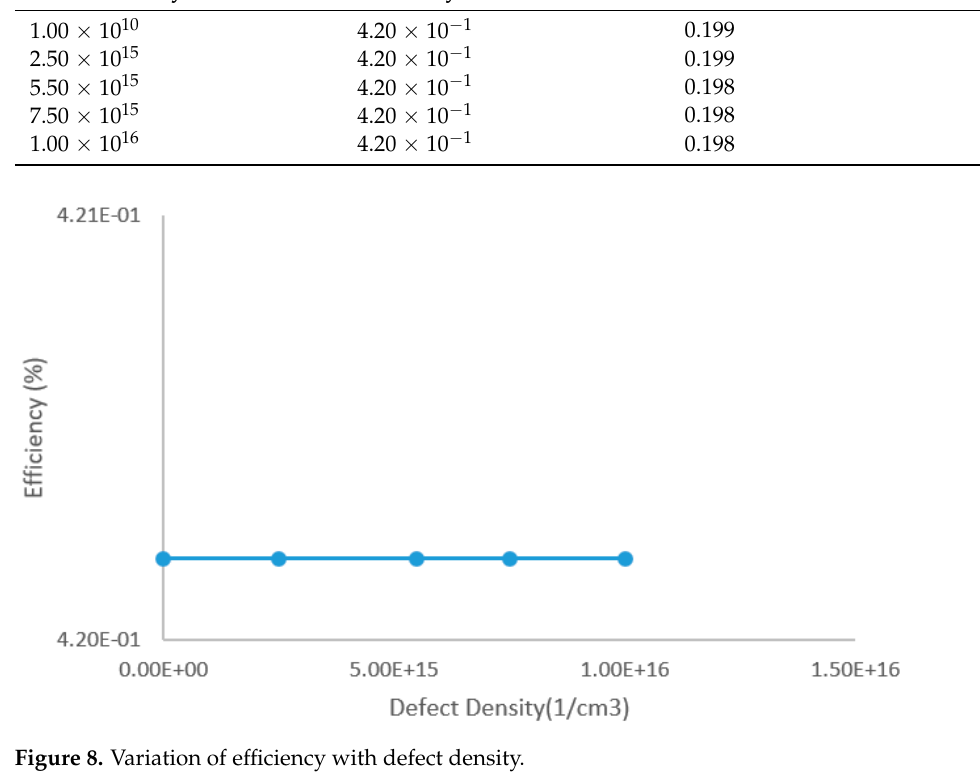
Figure 8. Variation of efficiency with defect density.